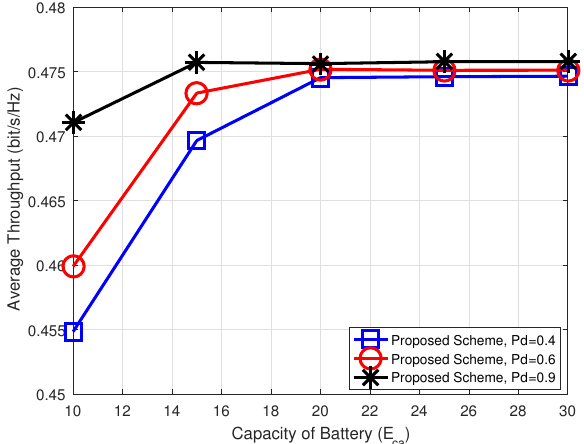
Proposed Scheme, Pd=0.4 Proposed Scheme, Pd=0.6 Proposed Scheme, Pd=0.9